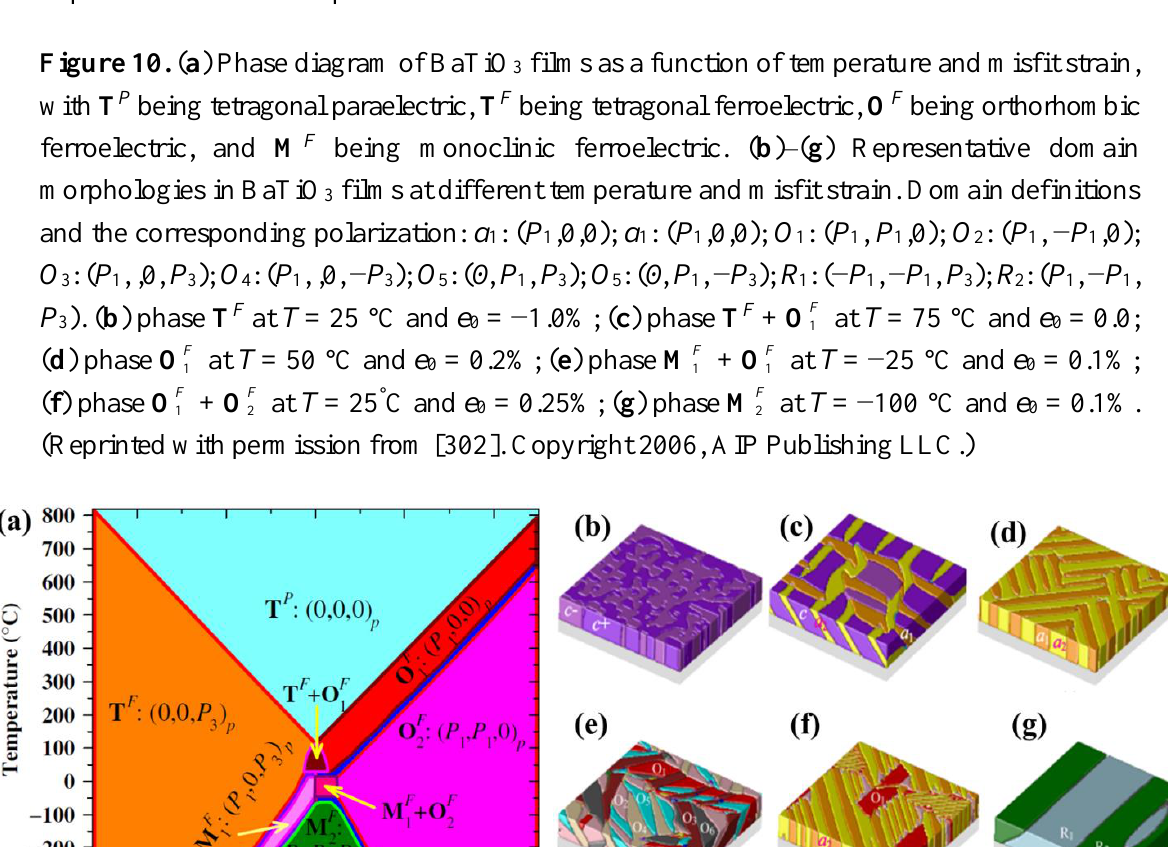
Figure 10. ( a ) Phase diagram of BaTiO 3 films as a function of temperature and misfit strain, with T P being tetragonal paraelectric, T F being tetragonal ferroelectric, O F being orthorhombic ferroelectric, and M F being monoclinic ferroelectric. ( b )–( g ) Representative domain morphologies in BaTiO 3 films at different temperature and misfit strain. Domain definitions and the corresponding polarization: a 1 : ( P 1 ,0,0); a 1 : ( P 1 ,0,0); O 1 : ( P 1 , P 1 ,0); O 2 : ( P 1 , − P 1